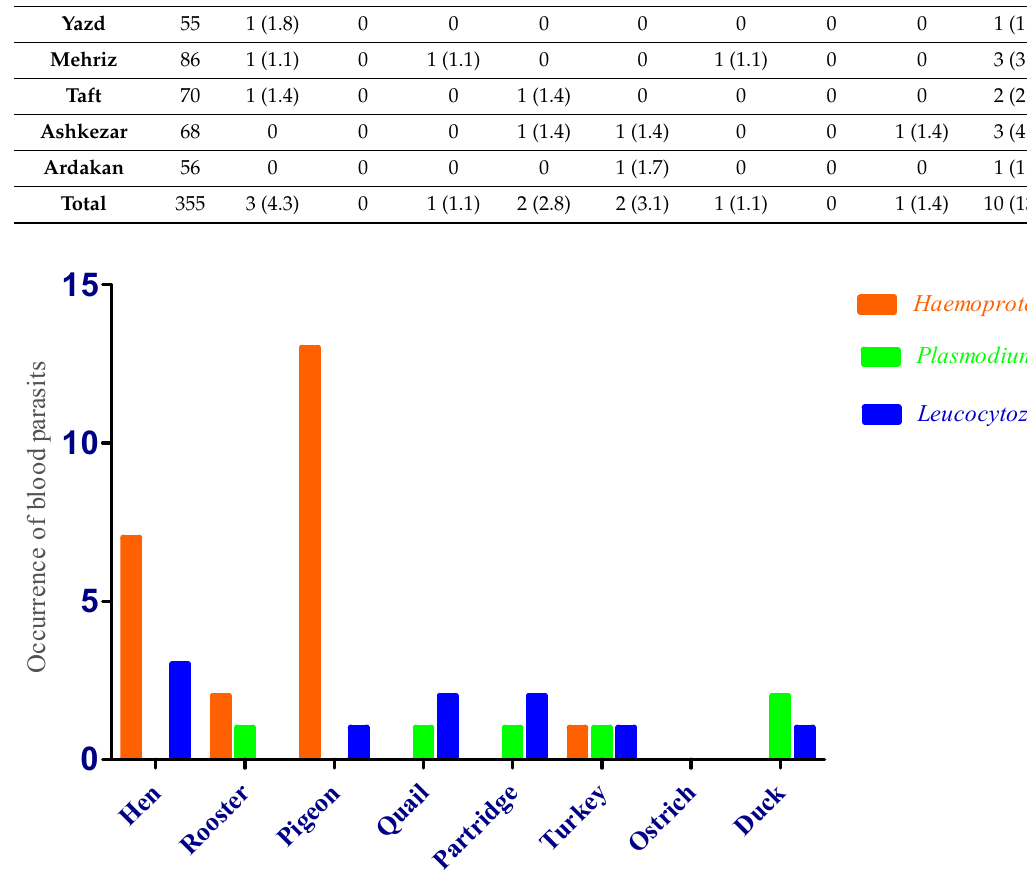
Table 3. Occurrence of Leucocytozoon ( Leuc ) parasite in eight species of birds located at five counties in Yazd province, central Iran. Occurrence of Leucocytozoon (Leuc) Parasite Location/Bird No. Types Hen Rooster Pigeon Quail Partridge Ostrich Duck